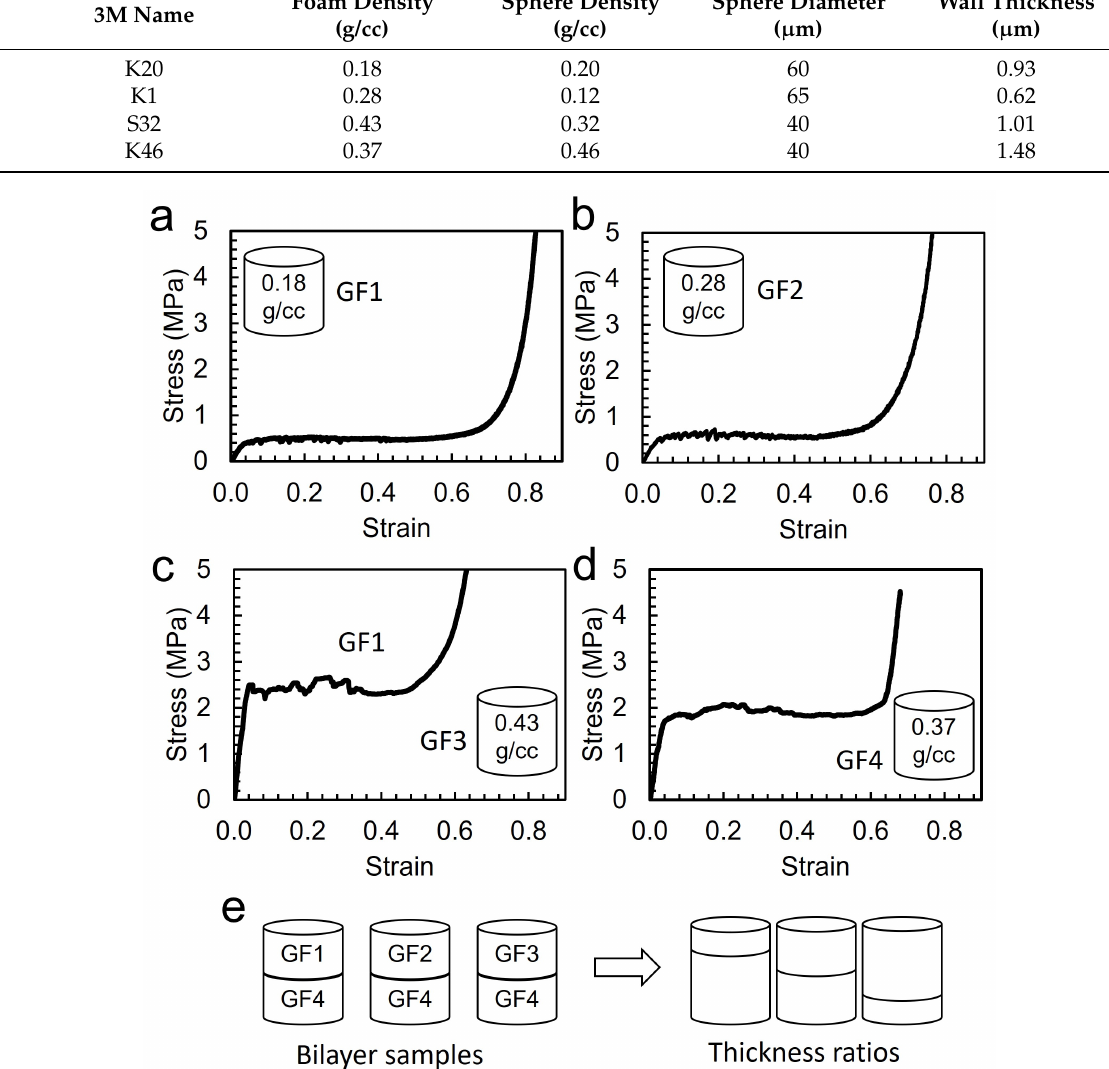
Figure 2. Stress–strain curves of ( a ) glass foam 1 (GF1) with 0.18 g/cc ( b ) GF2 with 0.28 g/cc ( c ) GF3 with 0.43 g/cc ( d ) GF4 with 0.37 g/cc. ( e ) configuration of bilayer glass foam using GF1-GF4 system and thickens ratios between the two